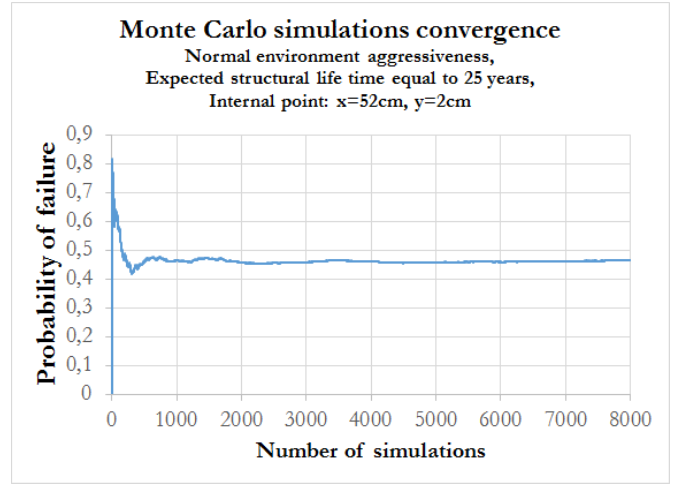
Figure 18 – Convergence analysis for x = 52 cm, y = 2 cm and t = 25 years.